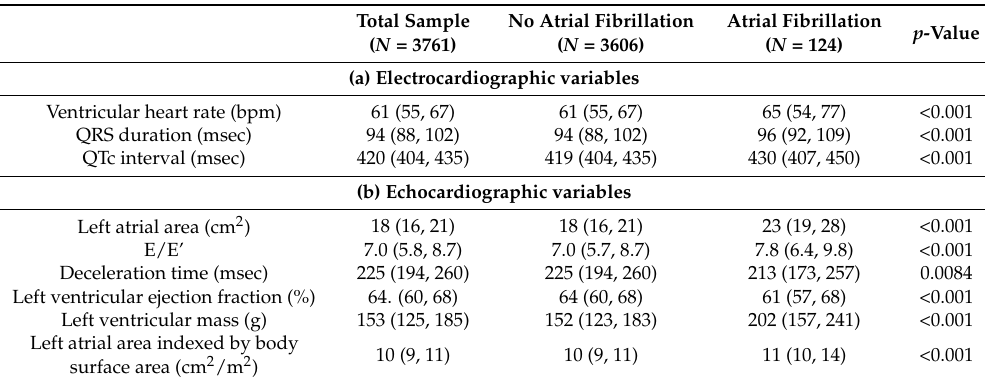
Table 2. Electrocardiographic and echocardiographic clinical variables by AF